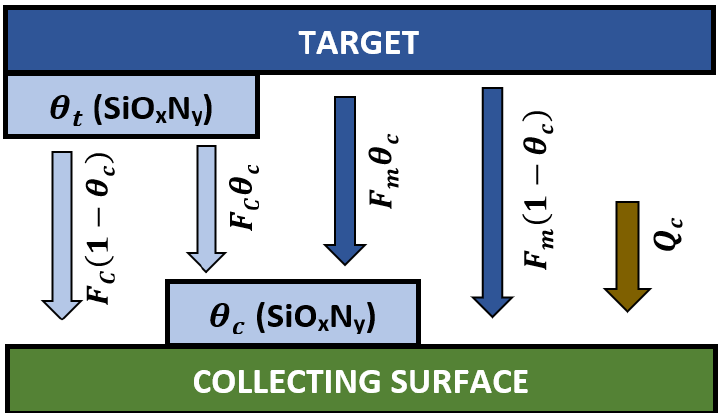
Figure 6. Schematic view of the material fluxes resulting SiO x N y formation on the collecting